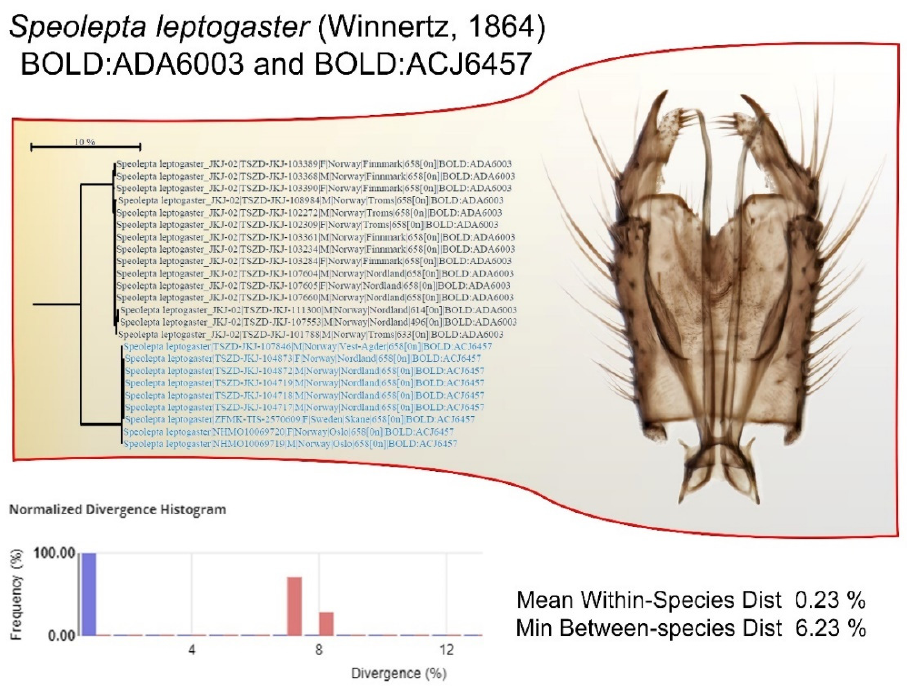
Figure 8. The cave-dwelling mycetophilid species Speolepta leptogaster (Winnertz, 1864) is an example of BIN splitting without any discernible morphological segregation. Two distinct BINs are separated with a minimum between-species distance of 6.23%, suggesting that two cryptic species are involved.